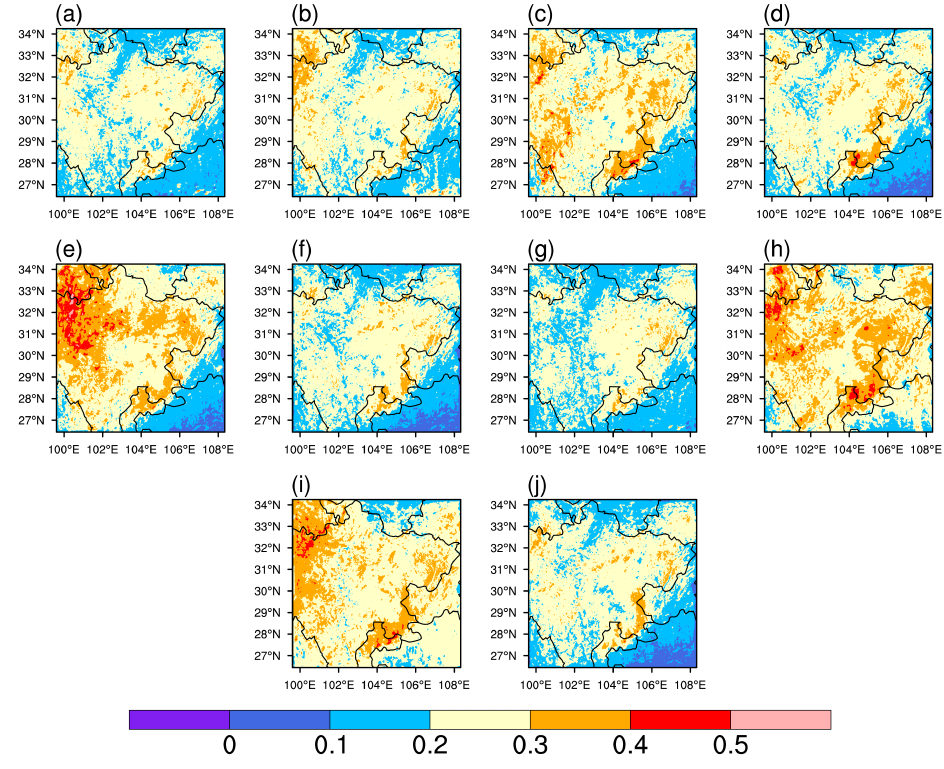
Figure 20. Spatial distribution of STD values for 24-h averaged 2-m dew point temperature ( ◦ C). Panels from ( a – j ) stand for P1 to P10,